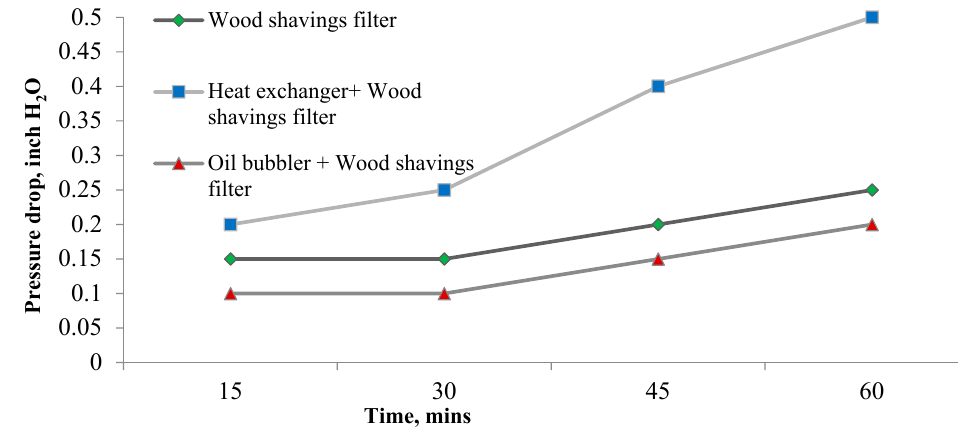
Figure 9. Variation of pressure drop of wood shavings filters over time.